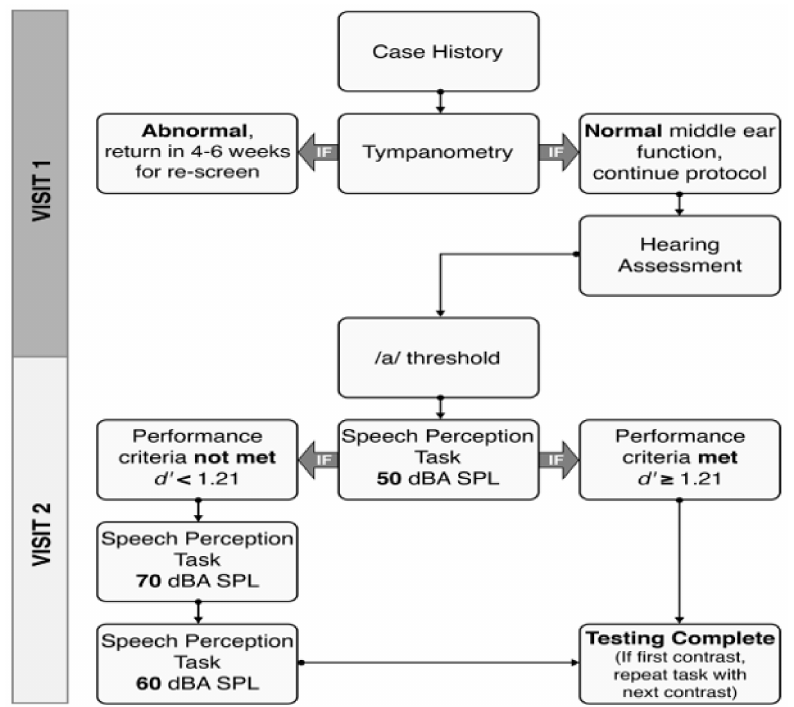
Figure 2. Flow-chart representing the testing protocol consisting of two visits: visit 1 is shown in the upper half of the chart and visit 2 in the lower half of the